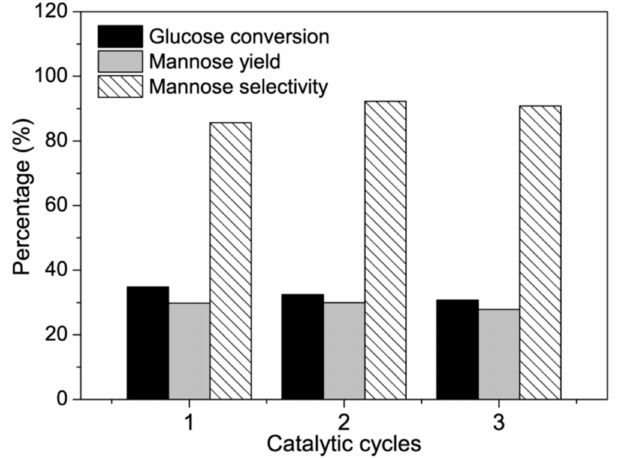
Figure 6. Recycling experiments over 13.3PMo / NH 2 -SBA-15. Reaction conditions: 40 mg of recycled catalyst, 5 mL of 5 wt% glucose solution, 120 ◦ C, 2 h.